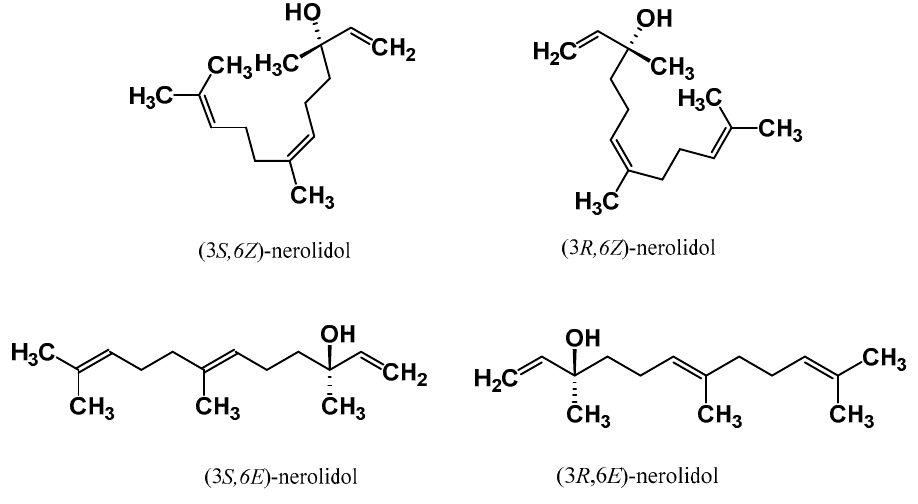
Figure 1. Chemical structures of the two enantiomers both for cis - and trans -isomers of nerolidol. Table 1. Synonyms of cis - and trans -nerolidol.